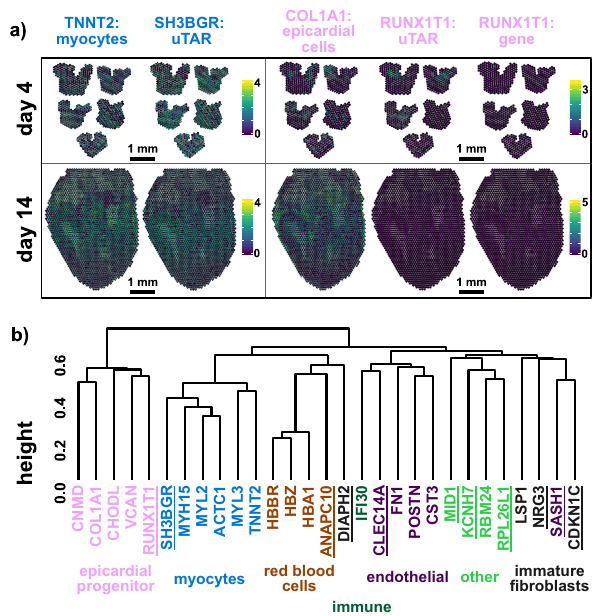
Fig. 4 Spatial transcriptomics to map uTAR expression in chicken embryonic hearts. a Spatial log-e-normalized expression of canonical TNNT2 myocytes marker, SH3BGR uTAR, canonical COL1A1 epicardial cells marker, RUNX1T1 uTAR, and annotated RUNX1T1 gene for chicken embryonic heart at day 4 (5 hearts) and day 14 (1 heart) post fertilization. b Dendrogram computed on Pearson correlation of log-e-normalized spatial expression for canonical gene markers and uTARs (underlined) in a day 4 chicken heart tissue